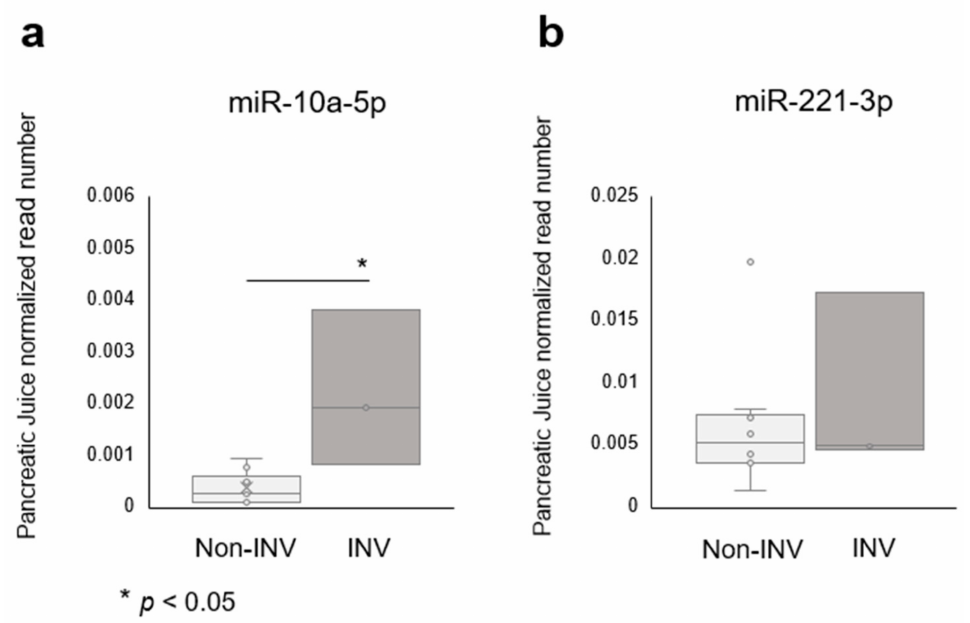
Figure 4. The miRNA expression of candidate biomarkers in intraductal papillary mucinous neo- plasm (IPMN) pancreatic juice samples. ( a ) MiR-10a-5p was significantly upregulated in inva- sive IPMN compared to noninvasive IPMN, and ( b ) miR-221-5p showed a similar tendency. INV, invasive